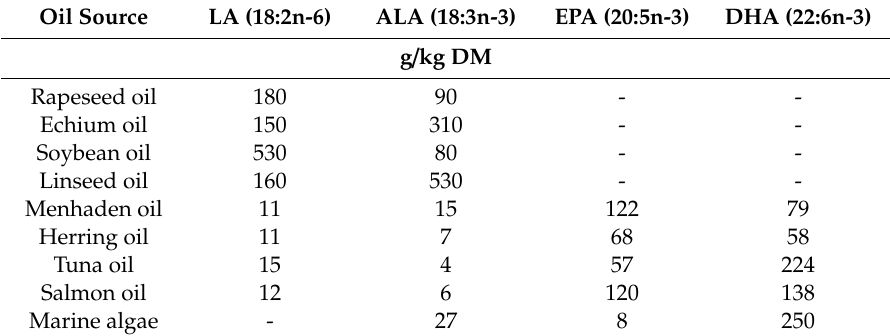
Table 2. Di ff erent sources of long-chain polyunsaturated fatty acids (LC PUFAs) in animal husbandry (adapted from